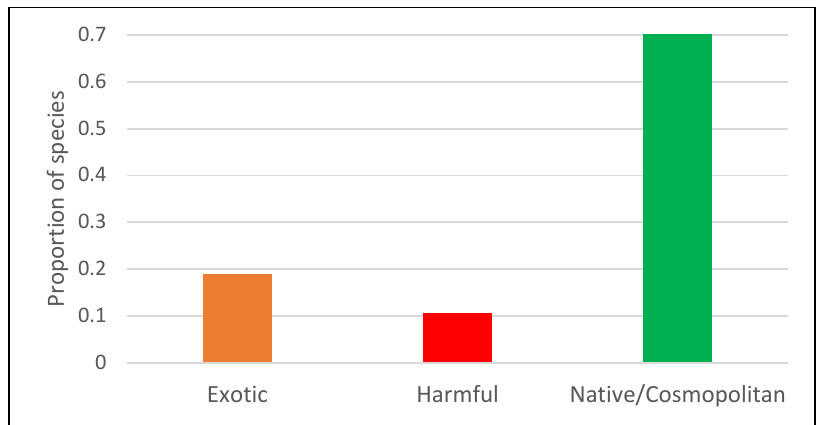
Figure 2. Proportion of algae species detected from eDNA in the ships analysed, for each type of alga considered (harmful algal bloom (HAB): Non-indigenous species (NIS), native from the NW Atlantic Ocean, the Baltic, and the North Sea).